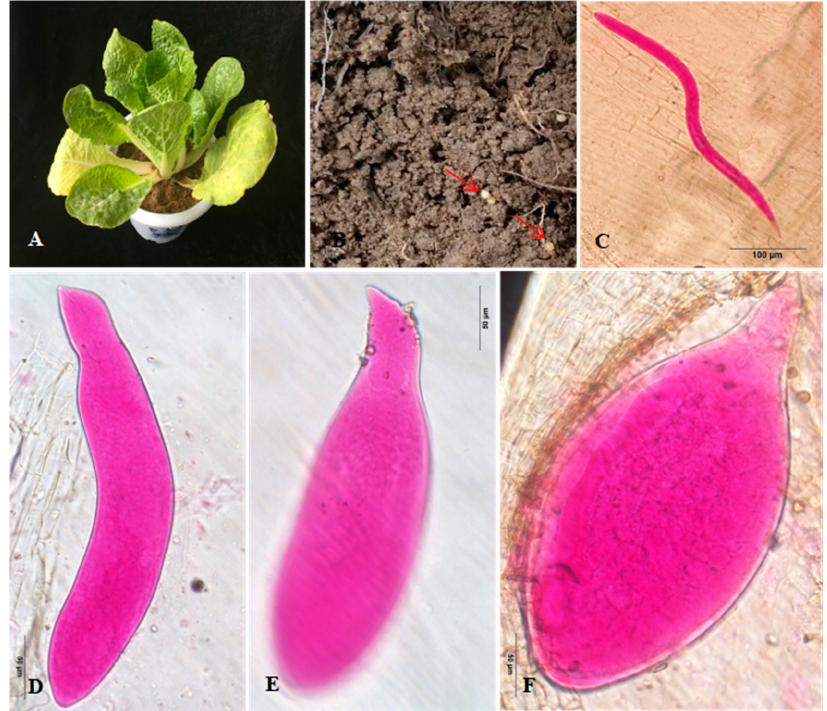
Figure 4. Symptoms of Chinese cabbage infested with SBCN. ( A ) Yellow leaves; ( B ) Cysts on roots; ( C ) Second-stage juvenile; ( D ) Third-stage juvenile; ( E ) Fourth-stage juvenile; ( F ) Female. Fourteen crop cultivars from five plant families were evaluated as hosts for SBCN, which are major crops in the Bashang region. After 45 days of growth, all nematodes were extracted from individual plants and counted. Out of the 14 crop cultivars tested, SBCN reproduced on two cultivars but did not reproduce on the other 12 cultivars. All nematode stages were observed on Chinese cabbage (cv. Linglonghuang012) and cabbage (cv. Chunwang), 37.8 ± 4.87 and 13.8 ± 2.39 females were isolated, respectively, and all nematode stages were significantly different. 33.2 ± 2.95 J2s, 34.8 ± 2.59 third-stage juveniles and 6.8 ± 1.48 fourth-stage juveniles were found in roots of soybean (cv. Zhonghuang13), except for female nematodes. Only J2s were isolated from roots of canola (cv. Lvguan1), kidney (cv. Baifeng, Jiulibai and Baibulao), zucchini (cv. Jinghu12 and Zaoqing1), cucumber (cv. Zhongnong18), tomato (cv. Zhongza9), on average, 14.4 ± 3.36, 126.6 ± 7.83, Table 4. Infection of Heterodera schachtii on different plants. 15.4 ± 2.41, 5.2 ± 1.30, 6.0 ± 2.24, 5.6 ± 1.82, 4.4 ± 1.14 and 11.4 ± 2.30 J2s were extracted, respectively. Potato (cv. Helan15), eggplant (cv. Junlang) and celery (cv. Yuhuang) were not infested (Table